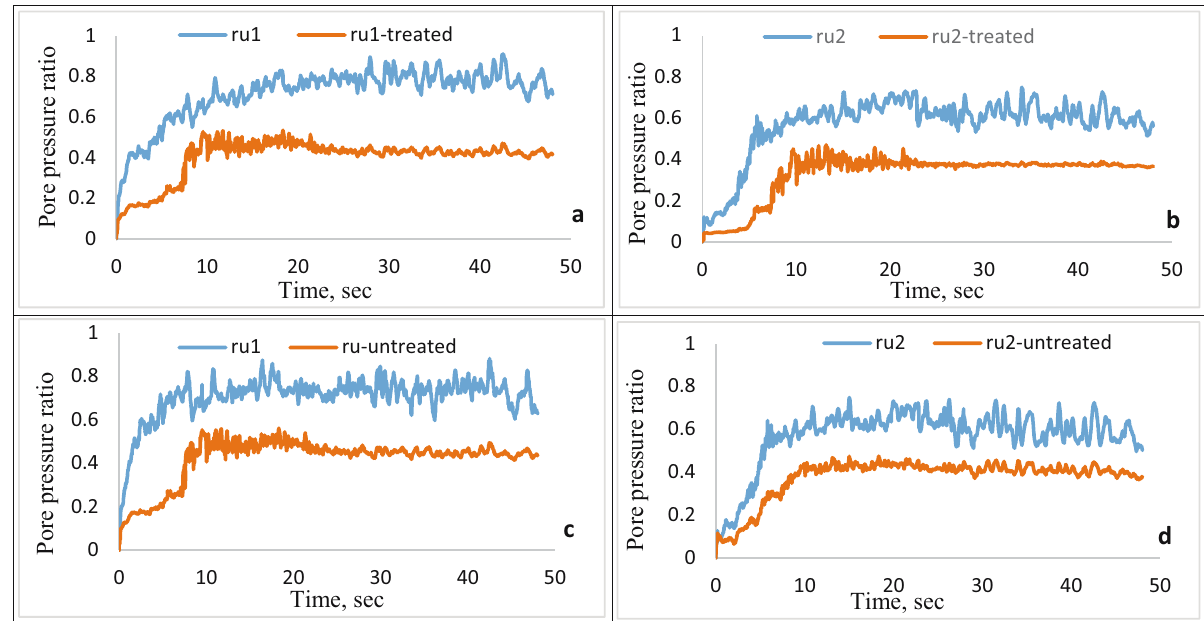
Figure 13: Pore pressure ratio within treated and untreated soil by nano - SiO 2 : ( a and b ) ru1 - and ru2 - treated at 50% axial load and 50% axial load and 100% lateral load; ( c and d ) ru1 - and ru2 - untreated at 100% axial load and 100% axial load and 100% lateral